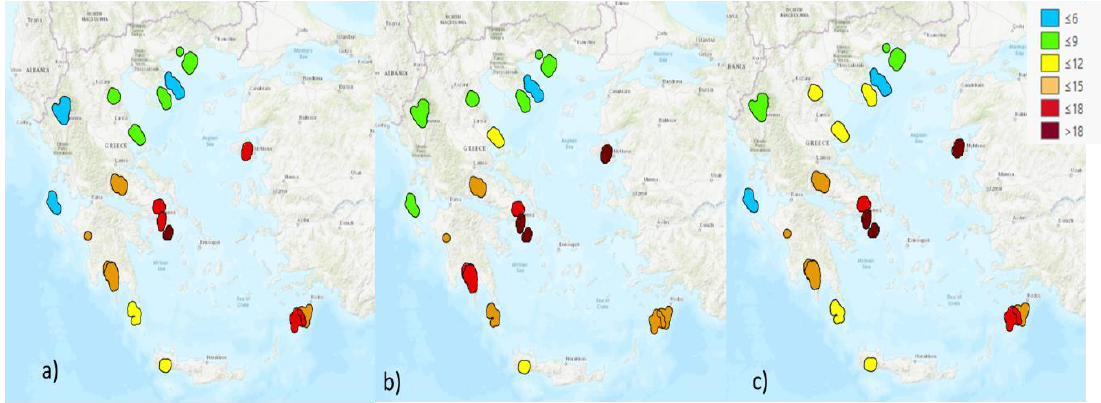
2036–2045 ( left ), historic period ( centre ), and RCP 8.5 2036–2045 ( right ).